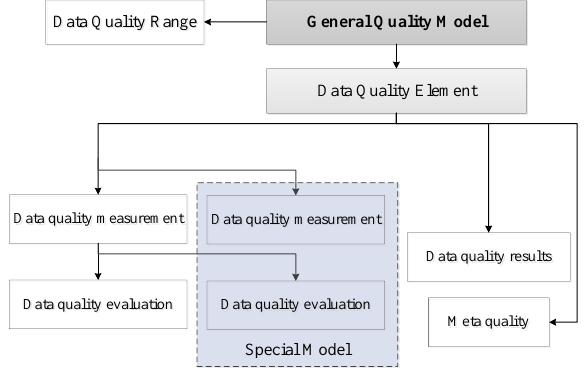
Figure 2 . Quality description framework of natural resources satellite remote sensing data and common products.